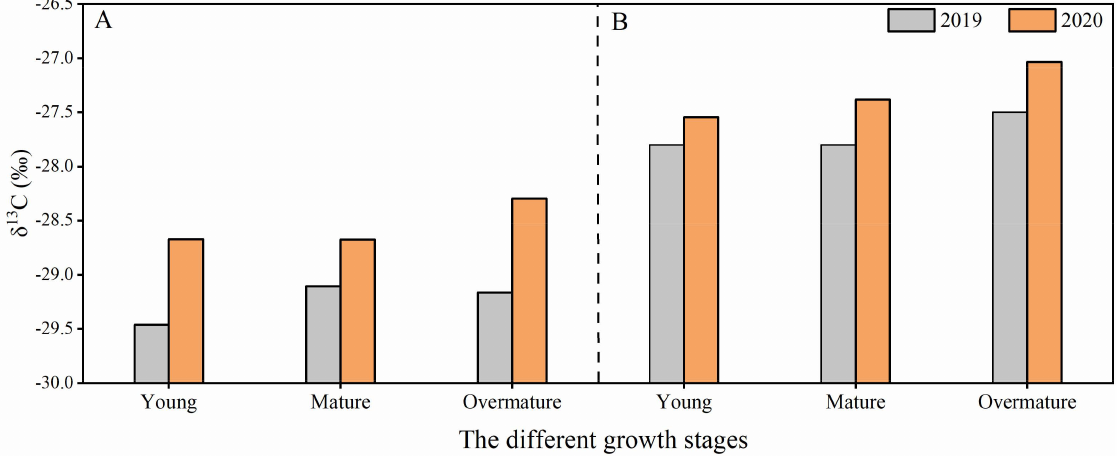
Figure 5. Variation in leaf δ 13 C values of P. euphratica ( A ) and T. chinensis ( B ) at different growth stages in 2019 and